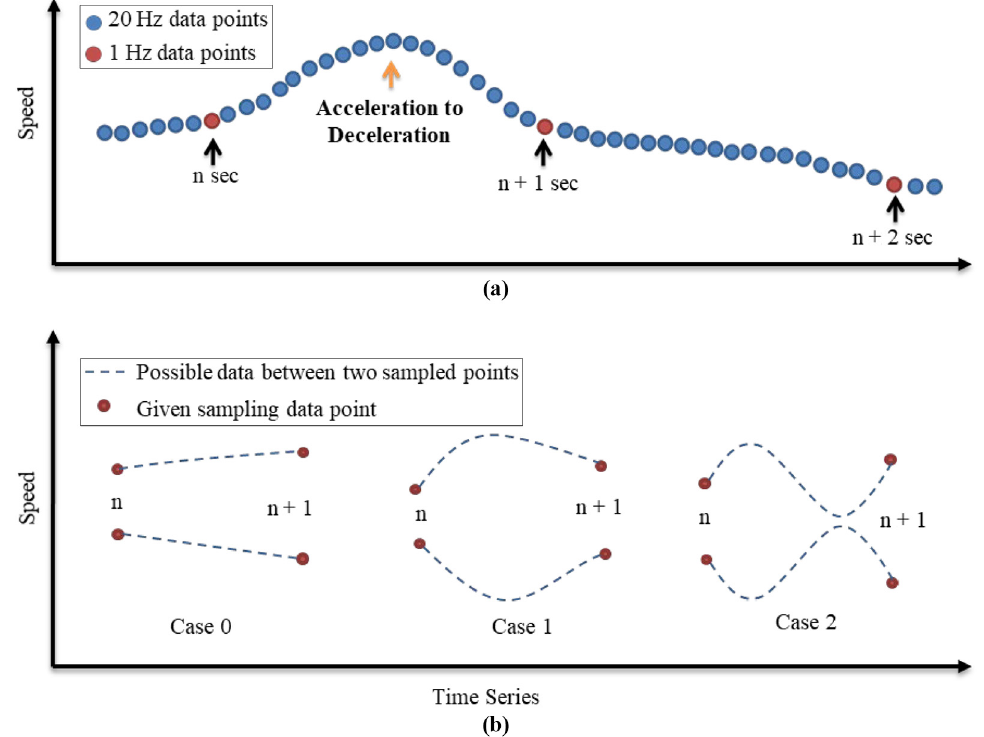
Figure 2 Example of information loss in instantaneous driving